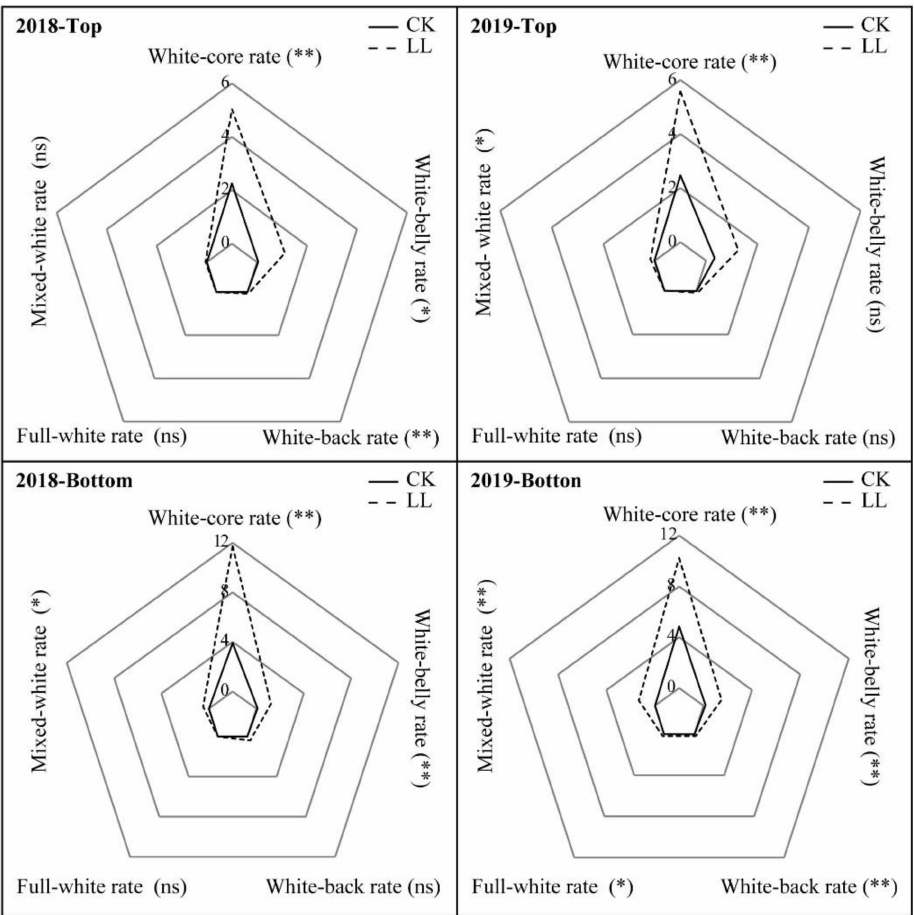
Figure 1. Variation in the rates of the chalkiness types of rice grains grown under LL stress in 2018 and 2019. CK, full sunlight control; LL, low light stress; * p < 0.05; ** p < 0.01; ns, no